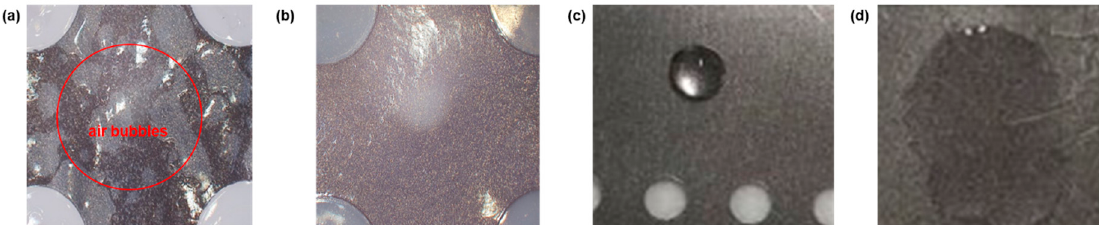
Figure 4. Photos of the surfaces of the g − TC films obtained ( a ) without and ( b ) with O 2 -plasma treatment; photos of water drops on the surfaces of the graphite sheets ( c ) before and ( d ) after oxygen plasma treatment .